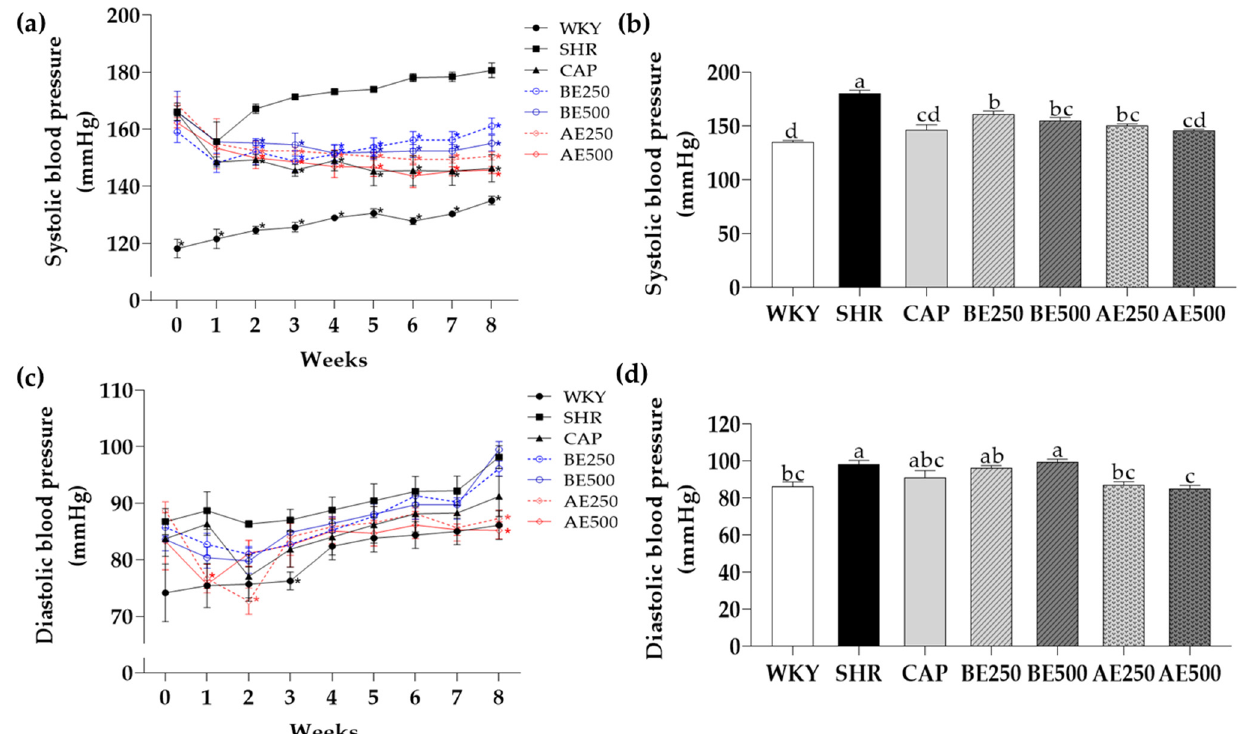
Figure 1. ( a ) Weekly systolic blood pressure, ( b ) systolic blood pressure at week 8, ( c ) weekly diastolic blood pressure, and ( d ) diastolic blood pressure at week 8 in the rats administered with black soybean or adzuki bean extracts. Data are expressed as mean ± SEM. * indicates a significant difference when compared to SHR group. The values with different letters indicate significant differences at p < 0.05. WKY: Wistar-Kyoto rats, SHR: Spontaneously hypertensive rats, CAP: 50 mg/kg body weight (bw) of captopril, BE250: 250 mg/kg bw of black soybean extracts, BE500: 500 mg/kg bw of black soybean extracts, AE250: 250 mg/kg bw of adzuki bean extracts, AE500: 500 mg/kg bw of adzuki bean extracts.